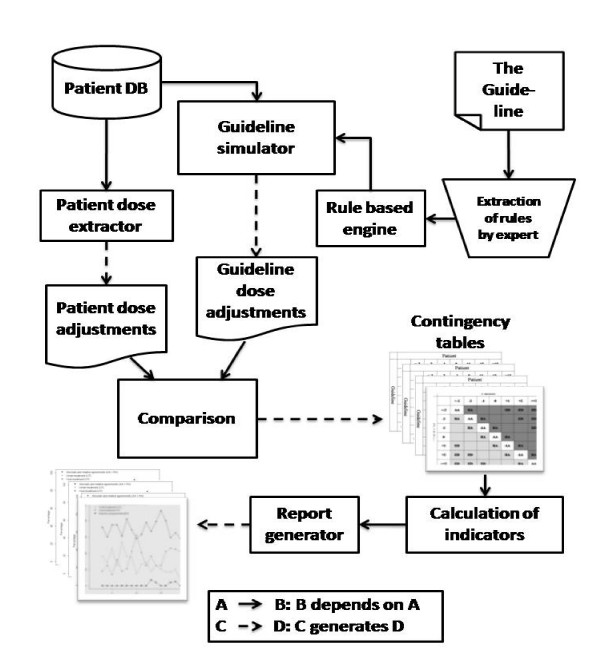
System architecture.